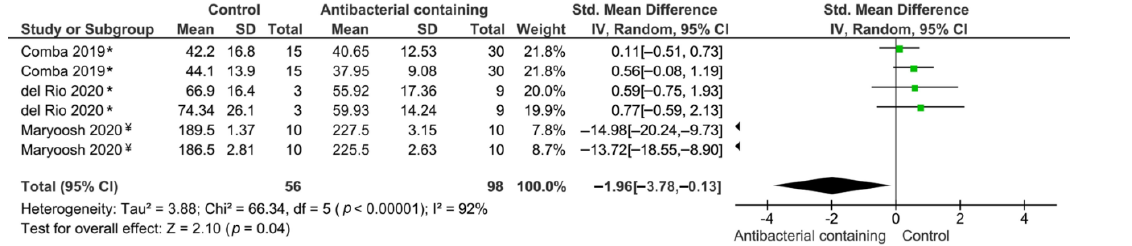
Figure 2. Results of the meta-analysis of the bond strength to dentin of universal adhesives modified with antibacterial agents. * Study used universal adhesives in both self-etch and etch-and-rinse modes; ¥ Study applied universal adhesives in etch-and-rinse mode.